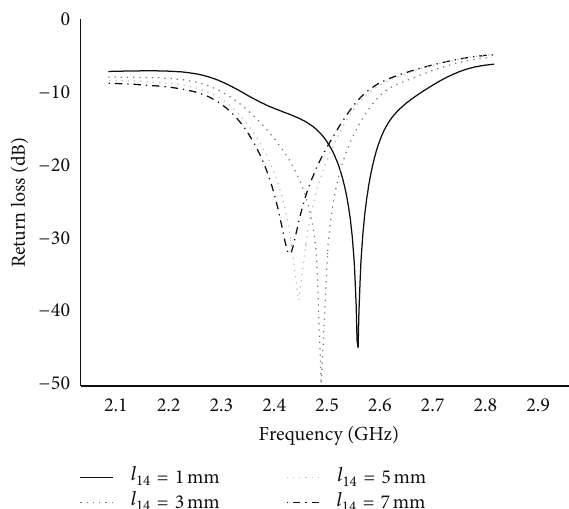
Figure 5: Length of CPW line impedance tuner 𝑙 14 effect on simulated return loss of four-element arrays without additional ground.